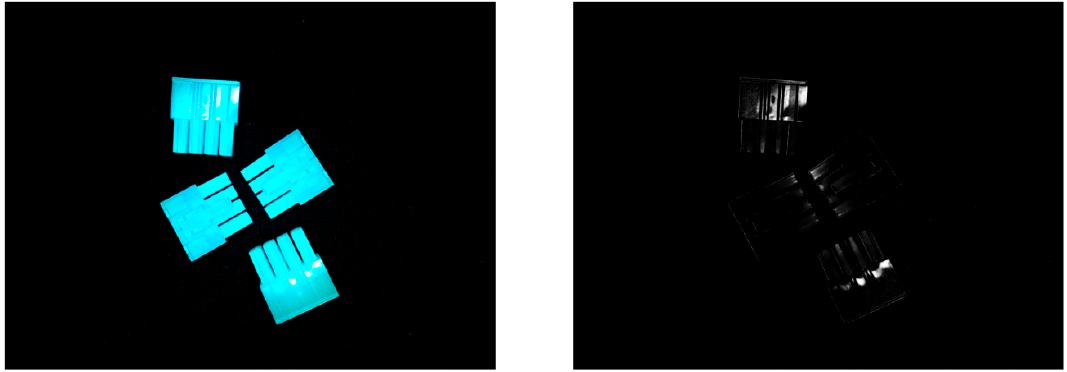
Figure 8. An image taken with no red component in illumination (illumination RGB were set to 0, 225, and 255, respectively), and its R-channel image.